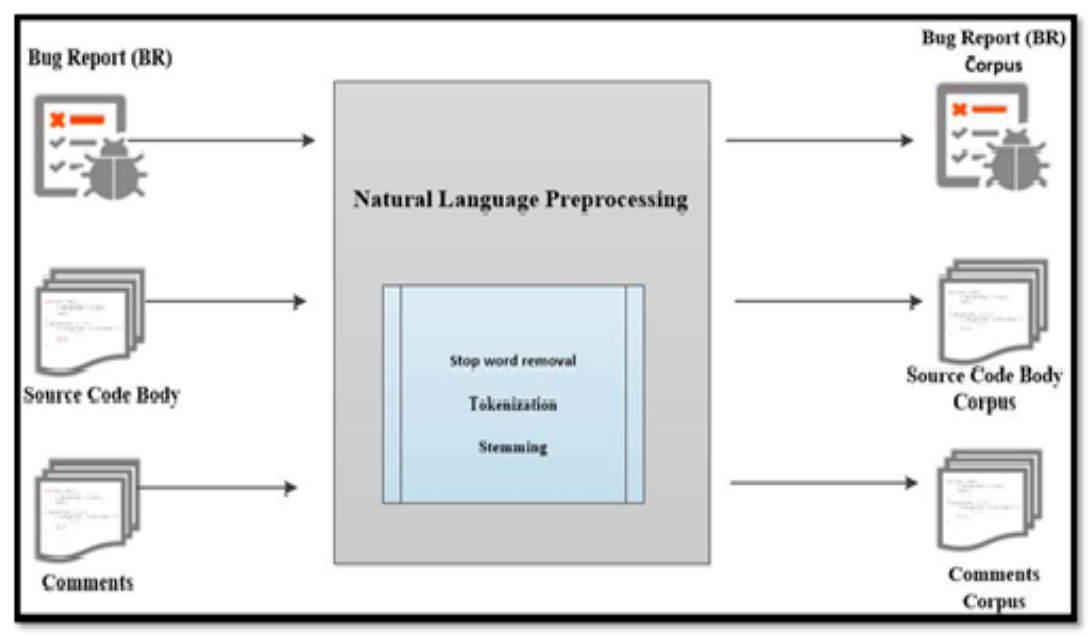
Figure 7. The preprocessing phase.